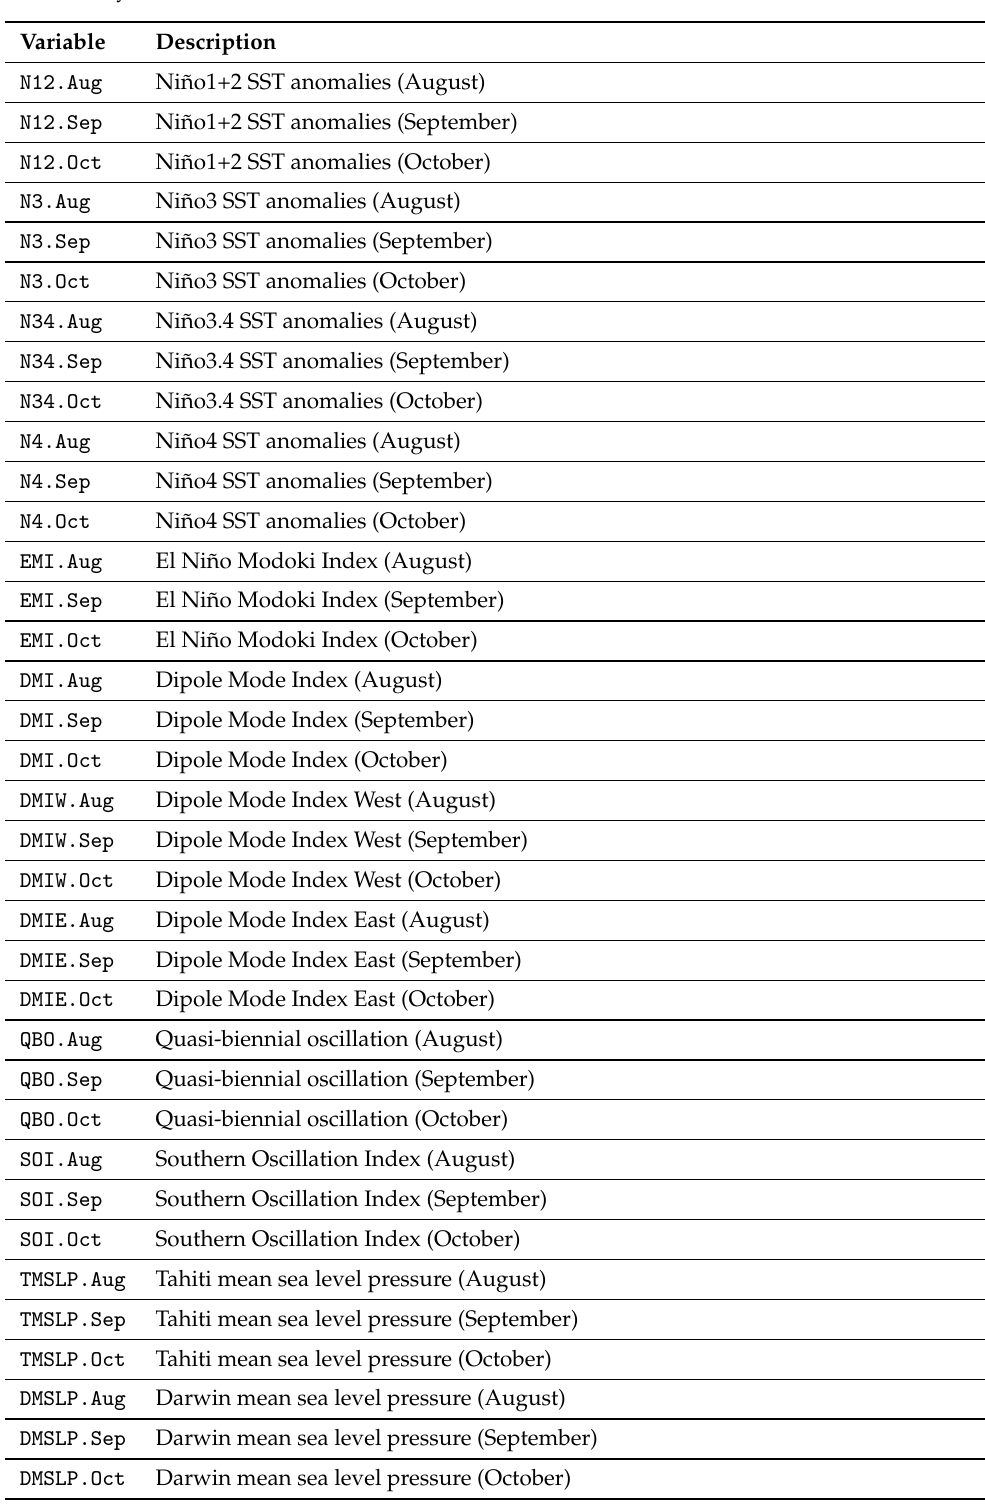
Table 1. List of the observed climate variables, in August, September and October each year, in this